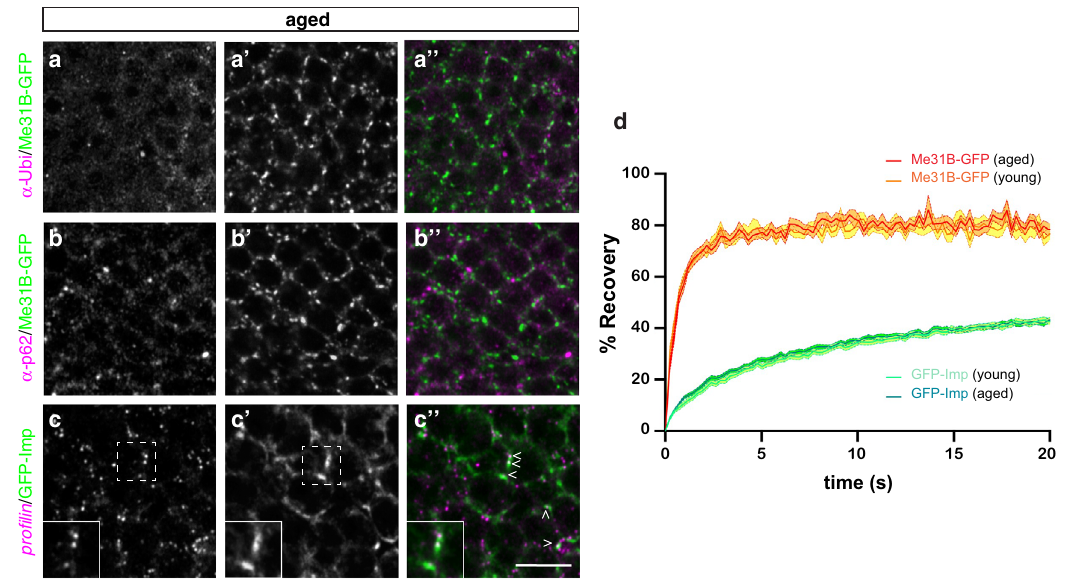
Fig. 2 Large granules in old fl ies are dynamic RNP assemblies. a – c Cell bodies of MB γ neurons imaged from 37 – 38 day-old (aged) brains. Me31B-GFP- expressing brains were stained with anti-Ubiquitin ( a , magenta in a ” ) antibodies, anti-p62 ( b , magenta in b ” ) antibodies, or pro fi lin smFISH probes ( c , magenta in c ” ). Me31B-GFP distribution is shown in white in a ’ - c ’ and in green in a ” - c ” . Arrowheads in c ” point to large granules containing pro fi lin mRNA. Insets show magni fi cations of the boxed region in c , c ’ . Two independent biological replicates were performed. Scale bar: 5 μ m. d Average FRAP curves obtained after photobleaching of GFP-Imp-positive (green) or Me31B-GFP-positive (red-orange) granules from 1 – 2 day- (young) or 38 day- (aged) old brain explants. A minimum of 90 granules from at least 9 brains were analyzed per condition. Error bars ( fi ll areas) represent s.e.m. Source data are provided as a Source Data fi